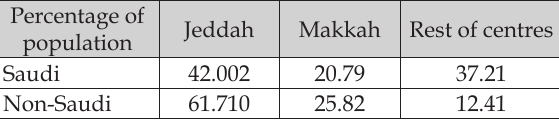
Table 1. Population distribution (Saudi/non-Saudi). Percentage of population